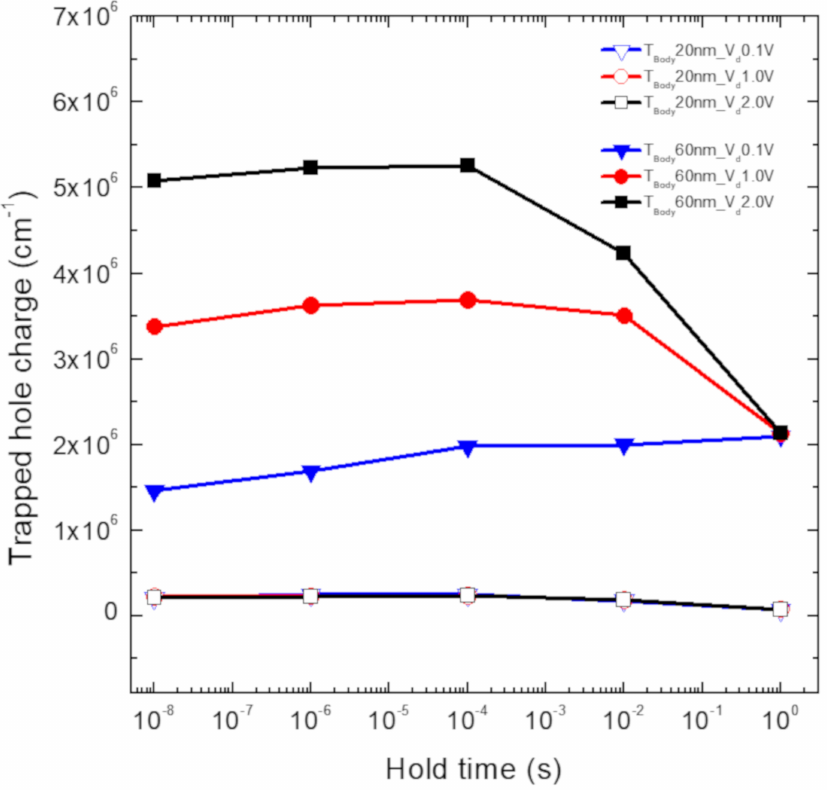
Figure 6. Transient hole trap charge density of the T Body 20 nm and T Body 60 nm devices in the Read”1” operation with varied Write”1” drain voltages.